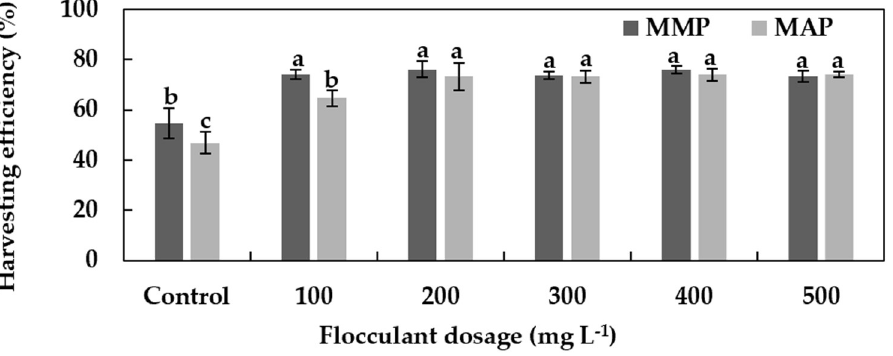
Figure 3. Effect of M. oleifera seed powder prepared with different grinding methods, manually- ground powder (MMP) and automatically-ground powder (MAP), on the harvesting efficiency of a mixed culture of Desmodesmus sp. and C. vulgaris (500 mg L − 1 ) after a 60-min sedimentation time. Control without the addition of flocculants was also carried out in the same conditions as the assays with the addition of flocculants. The rotation speed and time used were 150 rpm for 5 min, followed by 70 rpm for 20 min in an orbital shaker. Columns represent the average values, and error bars represent the standard deviations of triplicates. Different letters indicate significant differences between different dosages of Moringa powders using two different grinding methods after a one-way ANOVA followed by a Tukey test ( p <